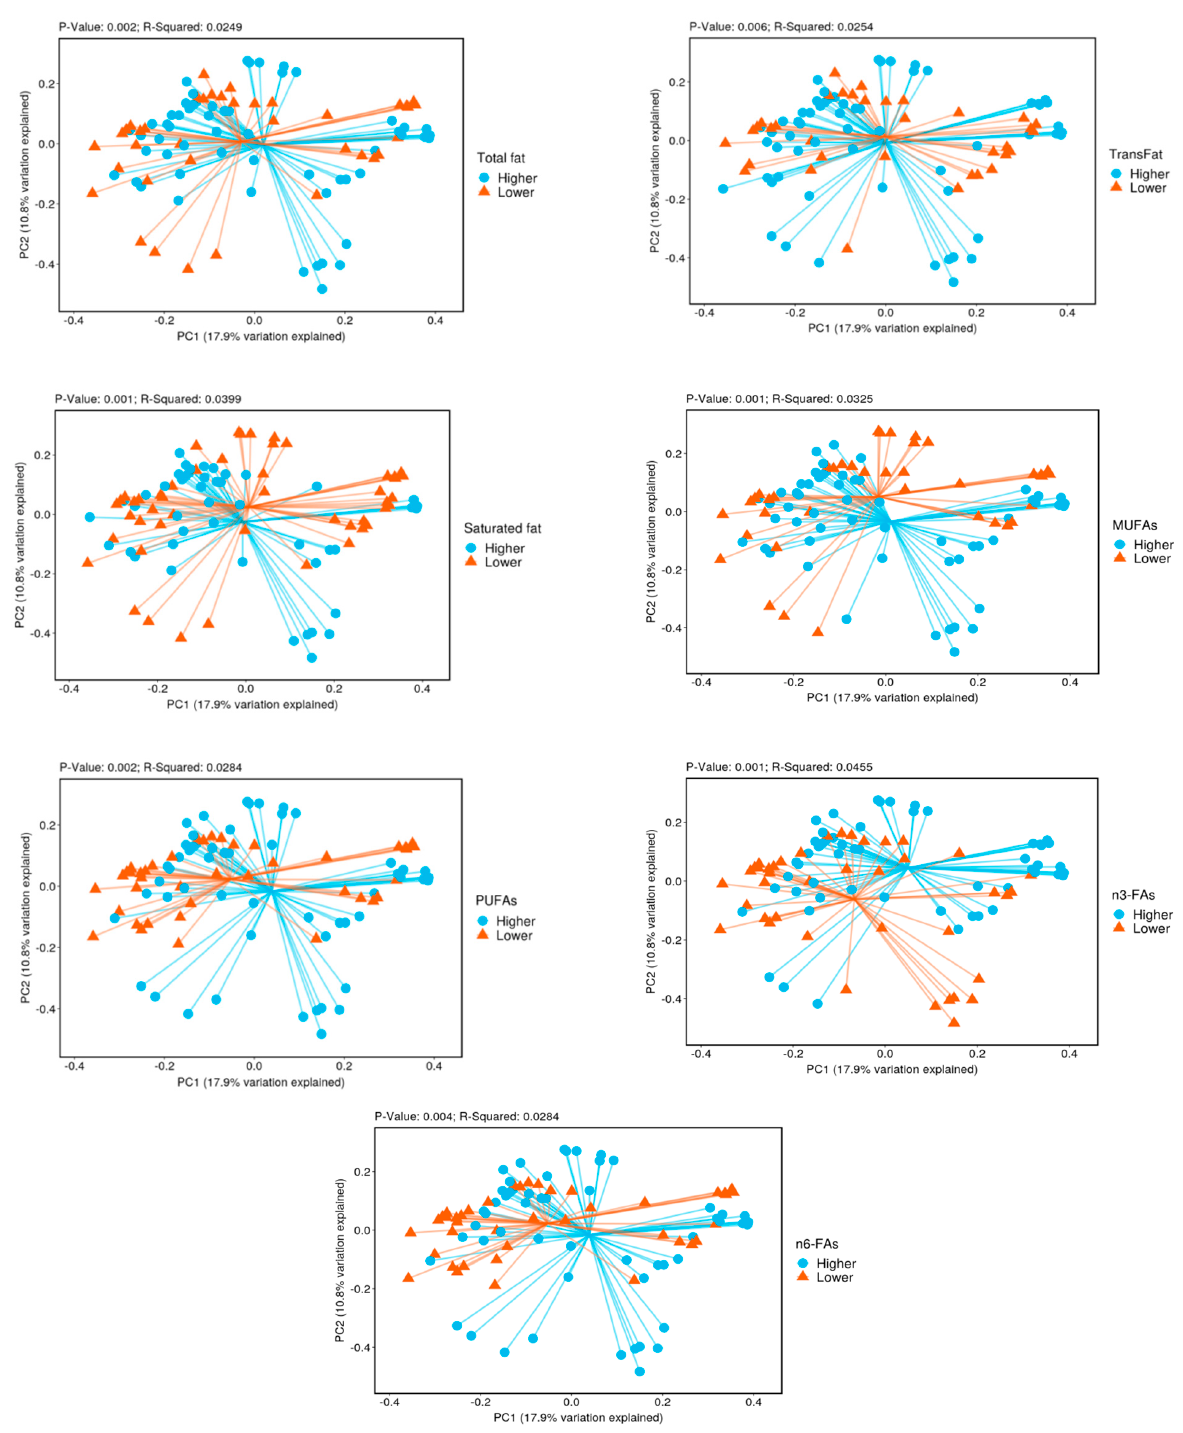
Figure 1. Beta diversity by lower vs. higher intake of fatty acids. Principal coordinate analysis (PCoA) with weighted Bray–Curtis dissimi- larity shows that the bacterial beta diversity differed significantly between higher vs. lower intake of multiple fatty acids ( p values ≤ 0.006, PERMANOVA test). The centroids of the two groups did not overlap. The fraction of diversity captured by the coordinate is shown as a percentage in the corresponding axis. PC1 and PC2 represent the top two principal coordinates that capture most of the diversity. 3.3. Taxonomy Seven phyla with relative abundance of greater than 0.5% were identified in our study sample. The relative abundance was 43.0% for Firmicutes, 35.6% for Bacteroidota, 9.00% for Proteobacteria, 3.18% for Verrucomicrobiota, 1.53% for both Fusobacteriota and Desulfobacterota, and 0.88% for Actinobacteriota. At the phylum level, Table 2 shows the relative abundance of Desulfobacteria was significantly higher with higher intake of TFAs, MUFAs, PUFAs, and n6-FAs. The relative abundance of Fusobacteria was signifi- cantly higher with higher intake of SFAs and MUFAs. At the family level, Supplemental Table 1 shows the relative abundance of Sutterellaceae and Desulfovibrionaceae was higher with higher intake of TFAs, MUFAs, PUFAs, and n6-FAs. The relative abundance of Fusobacteriaceae was higher with higher intake of SFAs and MUFAs. The relative abundance of Acidaminococcaceae was higher with higher intake of TFAs, PUFAs, n3-FAs, and n6-FAs. The relative abundance of Christensenellaceae was lower with higher intake of TFAs, TrFA, PUFAs, and n6-FAs. Other families, such as Prevotellaceae, Anaerovacaceae, Erysipelotrichaceae, and Ruminococcaceae, also differed significantly by fatty acid intake (Supplemental Table S1). Table 2. Relative abundance of bacterial phylum by fatty acid intake. Type of Fatty Acid Phylum